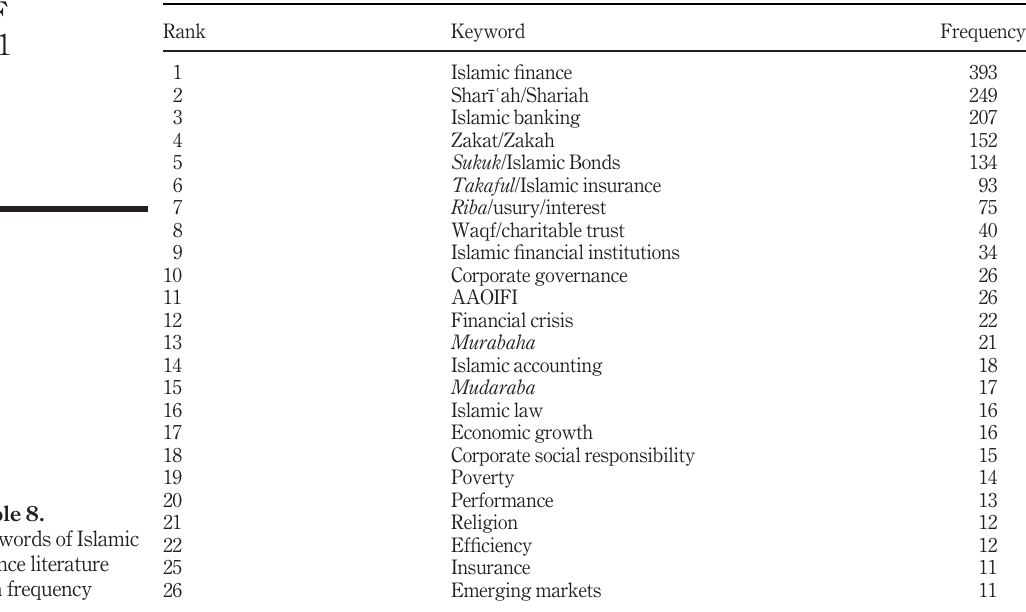
Table 8. Keywords of Islamic fi nance literature with